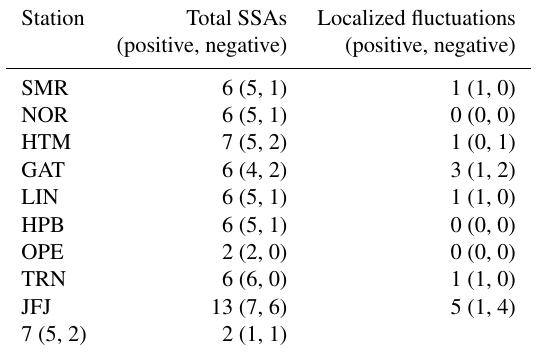
Table 2. Total number of SSAs in the CO 2 signal extracted by the ADA for the period 1 November 2015 to 31 March 2020 based on the ± 2 σ envelopes defined using the 30d smoothed seasonal cy- cle. Localized fluctuations are site-specific events with no analog at any other site (data must be present at a minimum of five sites for